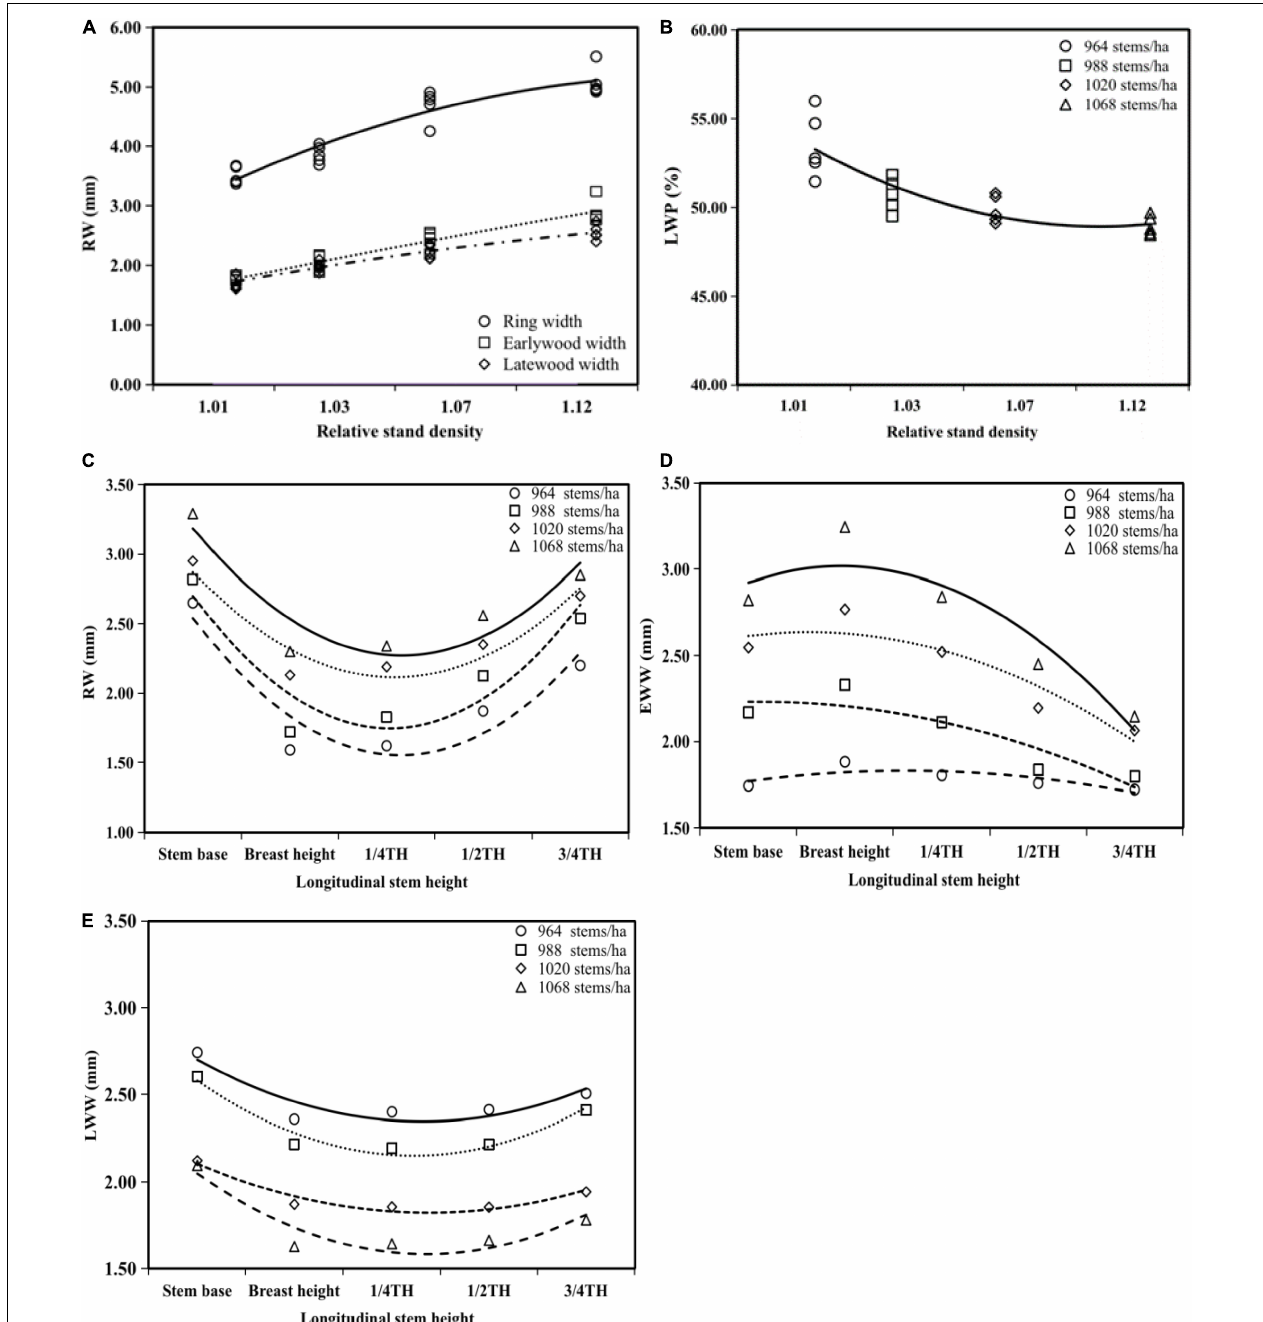
FIGURE 2 | Variation of ring width (RW), earlywood width (EWW), latewood width (LWW), and latewood proportion (LWP) in the radial and longitudinal stem directions during self-thinning trajectory of the even-aged pure S. tzumu stands. (A) Influence of stand density on RW. (B) Influence of stand density on LWP. (C) Influence of stem height on RW. (D) Influence of stem height on EWW. (E) Influence of stem height on